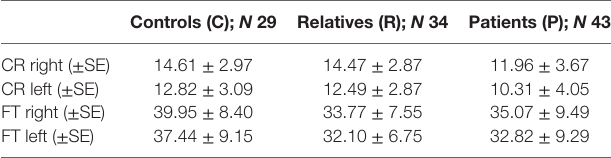
Table 4 | Performance of fine motor function in patients, relatives and controls. controls (c); N 29 relatives (r); N 34 Patients (P); N 43 CR right ( ± SE)